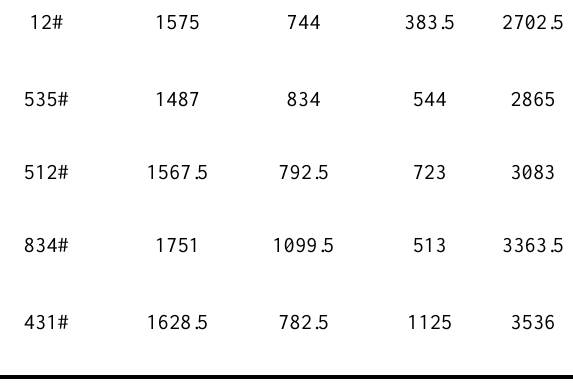
Table 9 Duration of abnormal conditions of RH in hours